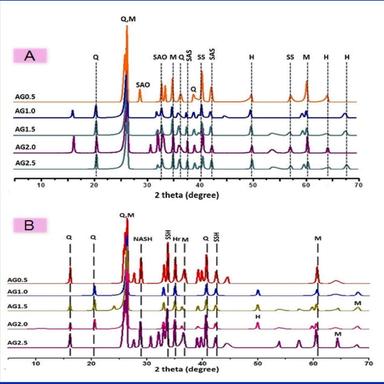
XRD spectra of designed geopolymer compositions by varying sodium hydroxide to sodium silicate ratios. (A) XRD graph of dry geopolymer precursor mixes and (B) XRD graph of geopolymeric coating material. Key- Q: quartz, M: mullite, H: hematite, SAO: sodium aluminium oxide, SAS: sodium aluminium silicate, SS: sodium silicate, SSH: sodium silicate hydrate, Hr: herschelite, NASH: sodium aluminium silicate hydrate. (Please see SI Table S2 for details of identified XRD phases).